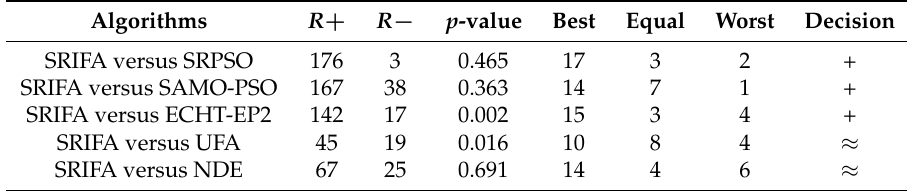
Table 7. Results obtained by a Wilcoxon-test for SRIFA against SRPSO, SAMO-PSO, ECHT-EP2, UFA and